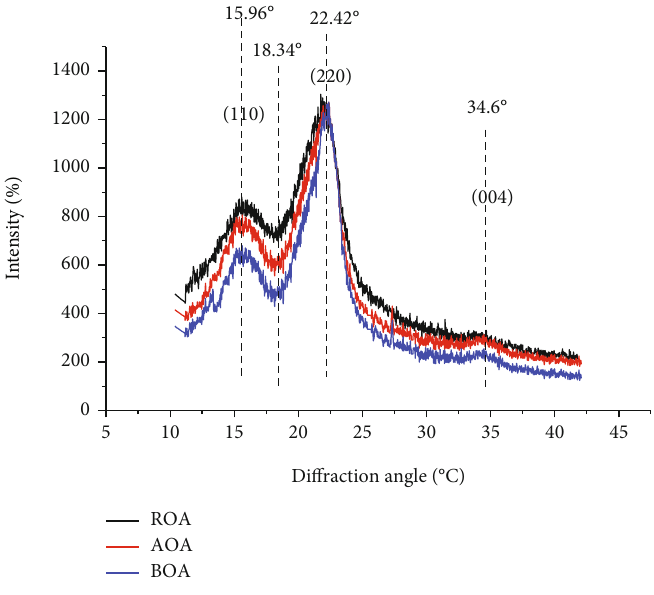
Figure 8: XRD pattern of ROA, AOA, and DOA.